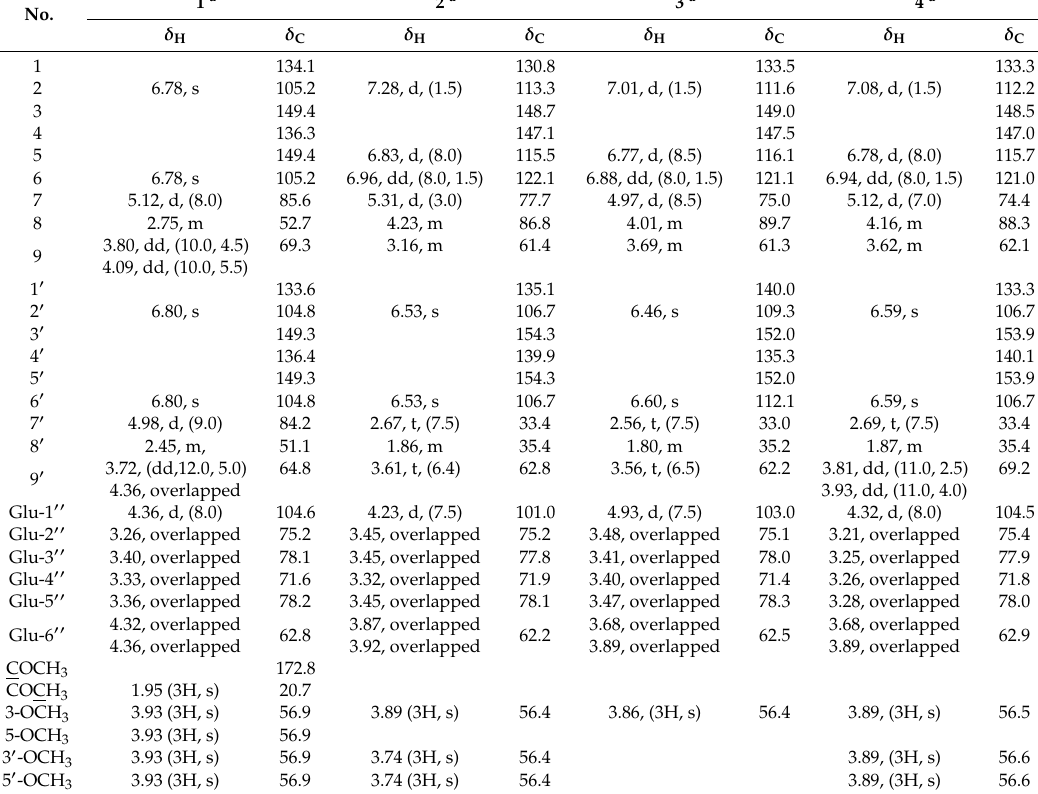
Table 1. Data of compounds 1 – 4 (500 MHz for 1 H and 125 MHz for 13 C, CD 3 OD, J in